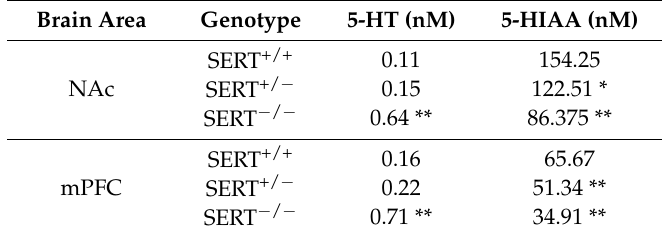
Table 1. Baseline levels of 5-HT and 5-HIAA (nM) in the NAc and mPFC. The groups SERT − / − and SERT − /+ were compared to SERT +/+ . Significance is described as * p < 0.05 and ** p < 0.01. Brain Area